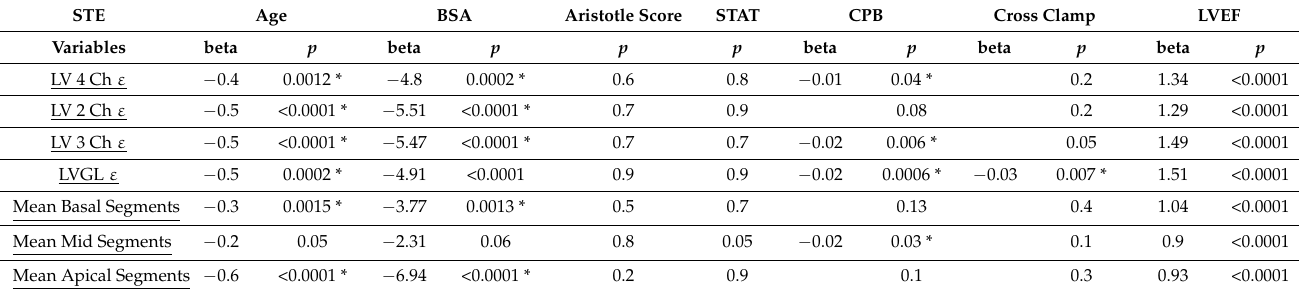
LV = left ventricle, 4 Ch = left ventricle four-chamber view, 2 Ch = two-chamber view, 3 Ch = three-chamber view, LVGL = left ventricle global longitudinal strain, STE = Speckle Tracking Echocardiography. For the simplicity of the reader, ε are expressed as positive numbers in all the tables. *: statistically significant. Table A2. Correlation among LV STE ε values with age, BSA, surgical risk scores and parameters, and LVEF. STE Age BSA Aristotle Score Variables beta p beta LV 4 Ch ε − 0.4 LV 2 Ch ε −